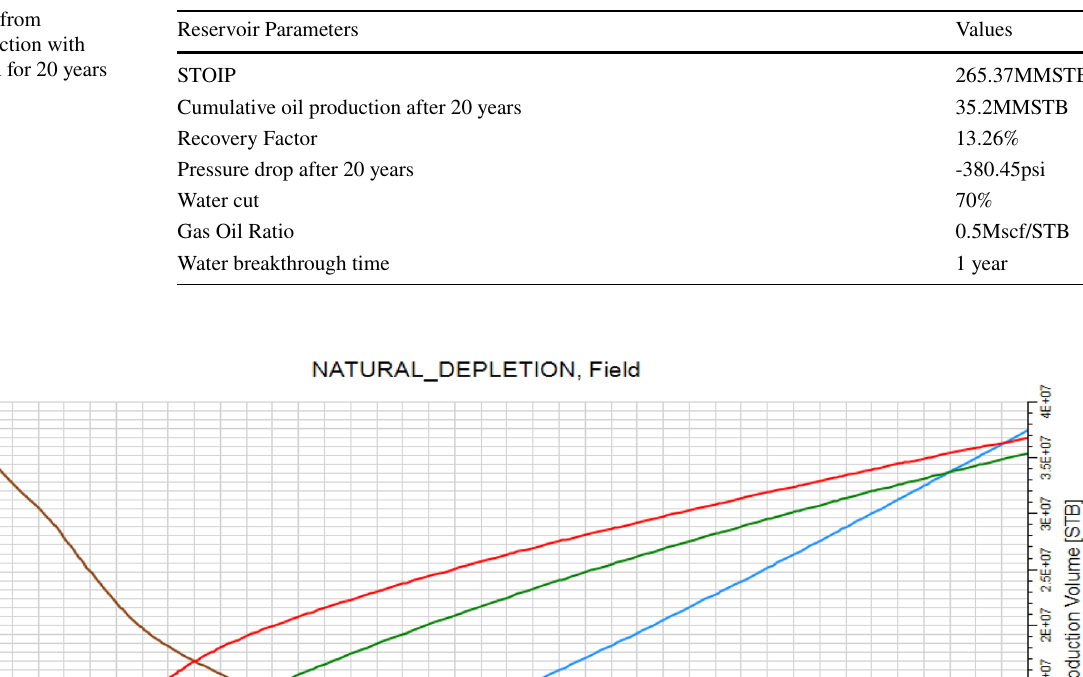
Reservoir Parameters